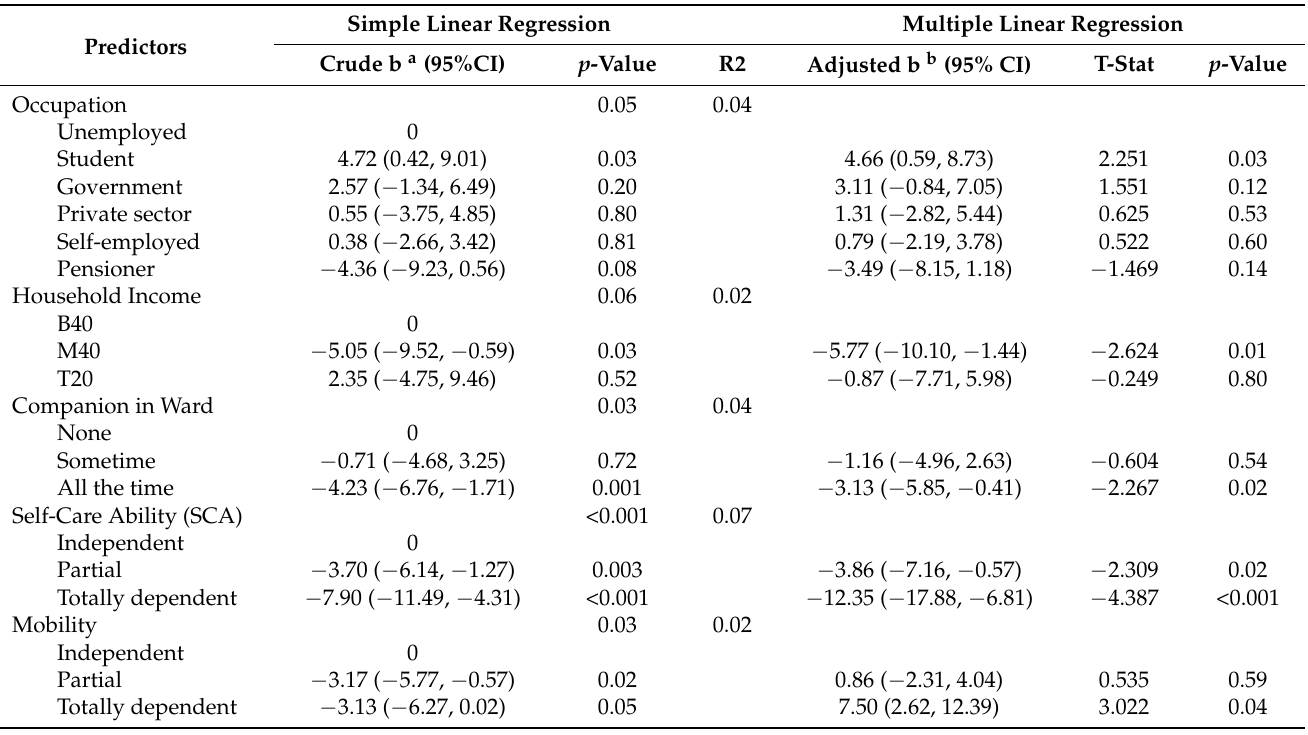
Table 5. Preliminary main effect model of compassionate care perceived by patients ( n =